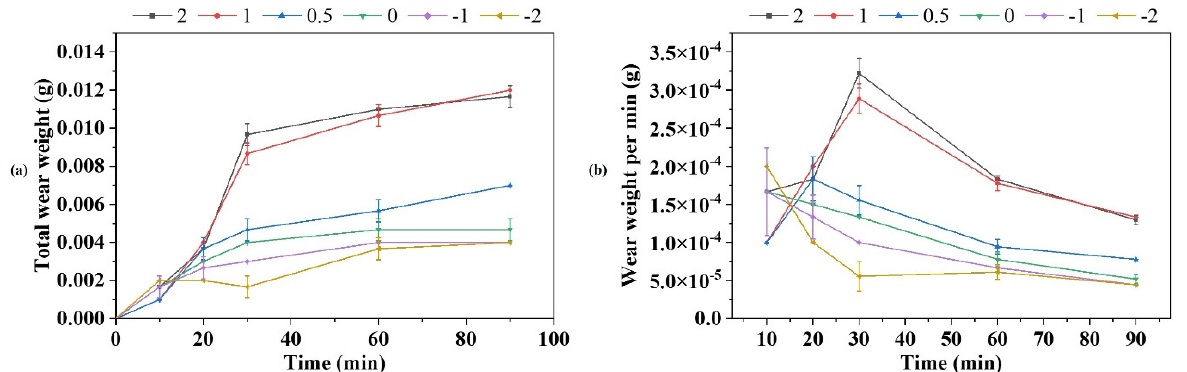
Figure 9. Wear weight comparison of the samples at the six positions shown in Figure 3 (3 samples at each position): ( a ) Total wear weight; ( b ) Wear weight per min.